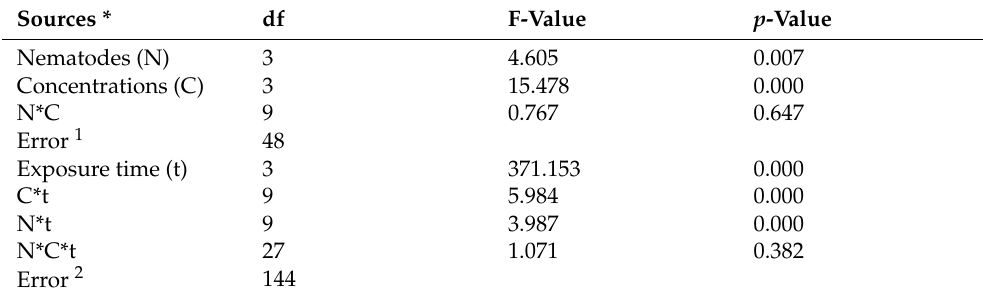
Table 5. Repeated measures analysis of variance parameters for the main effects and associated interactions for mortality rates of the 5th instar larvae of Cyida pomonella in Petri dish bioassay.